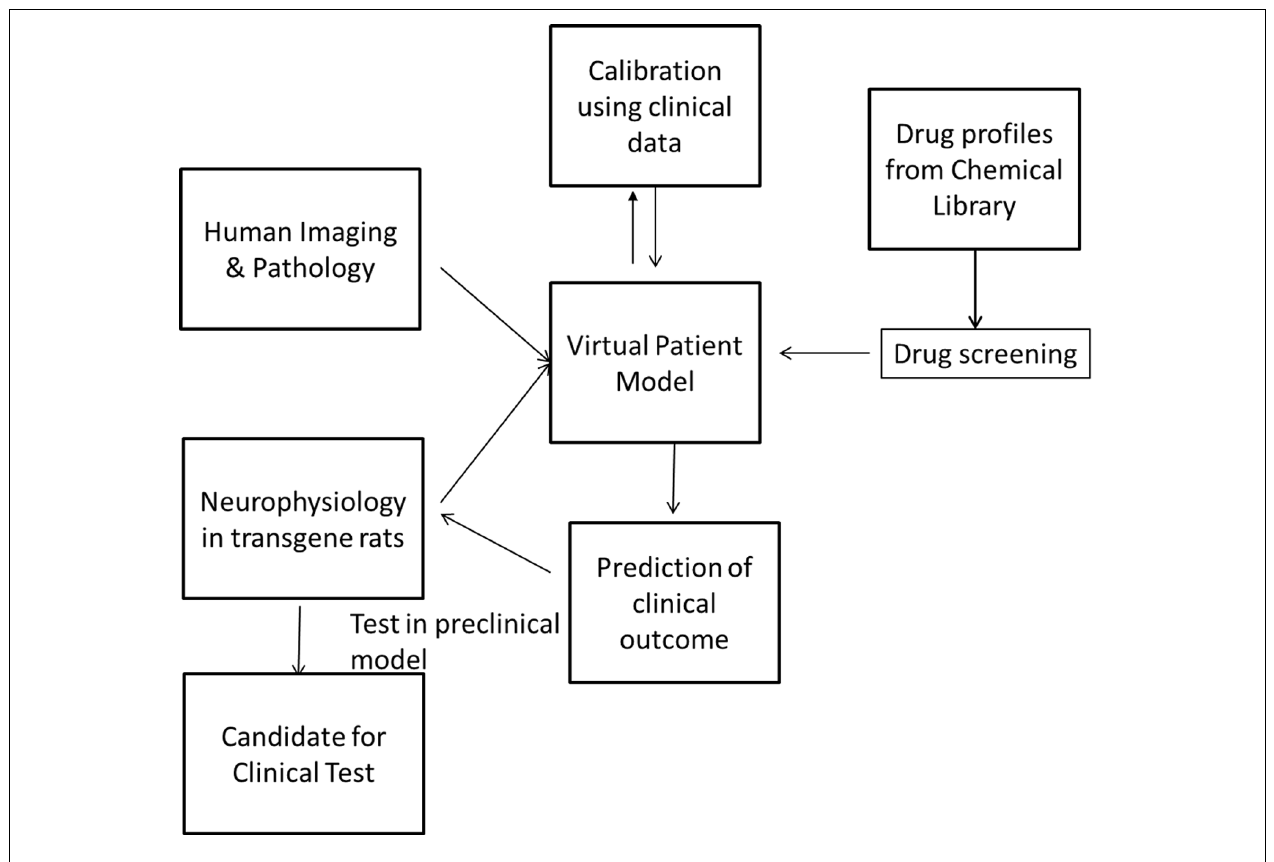
FIGURE 1 | Screening can be performed by simulating the pharmacology of existing drugs from chemical libraries such as the Prestwick library and identifying these with the greatest beneficial effect on the clinical